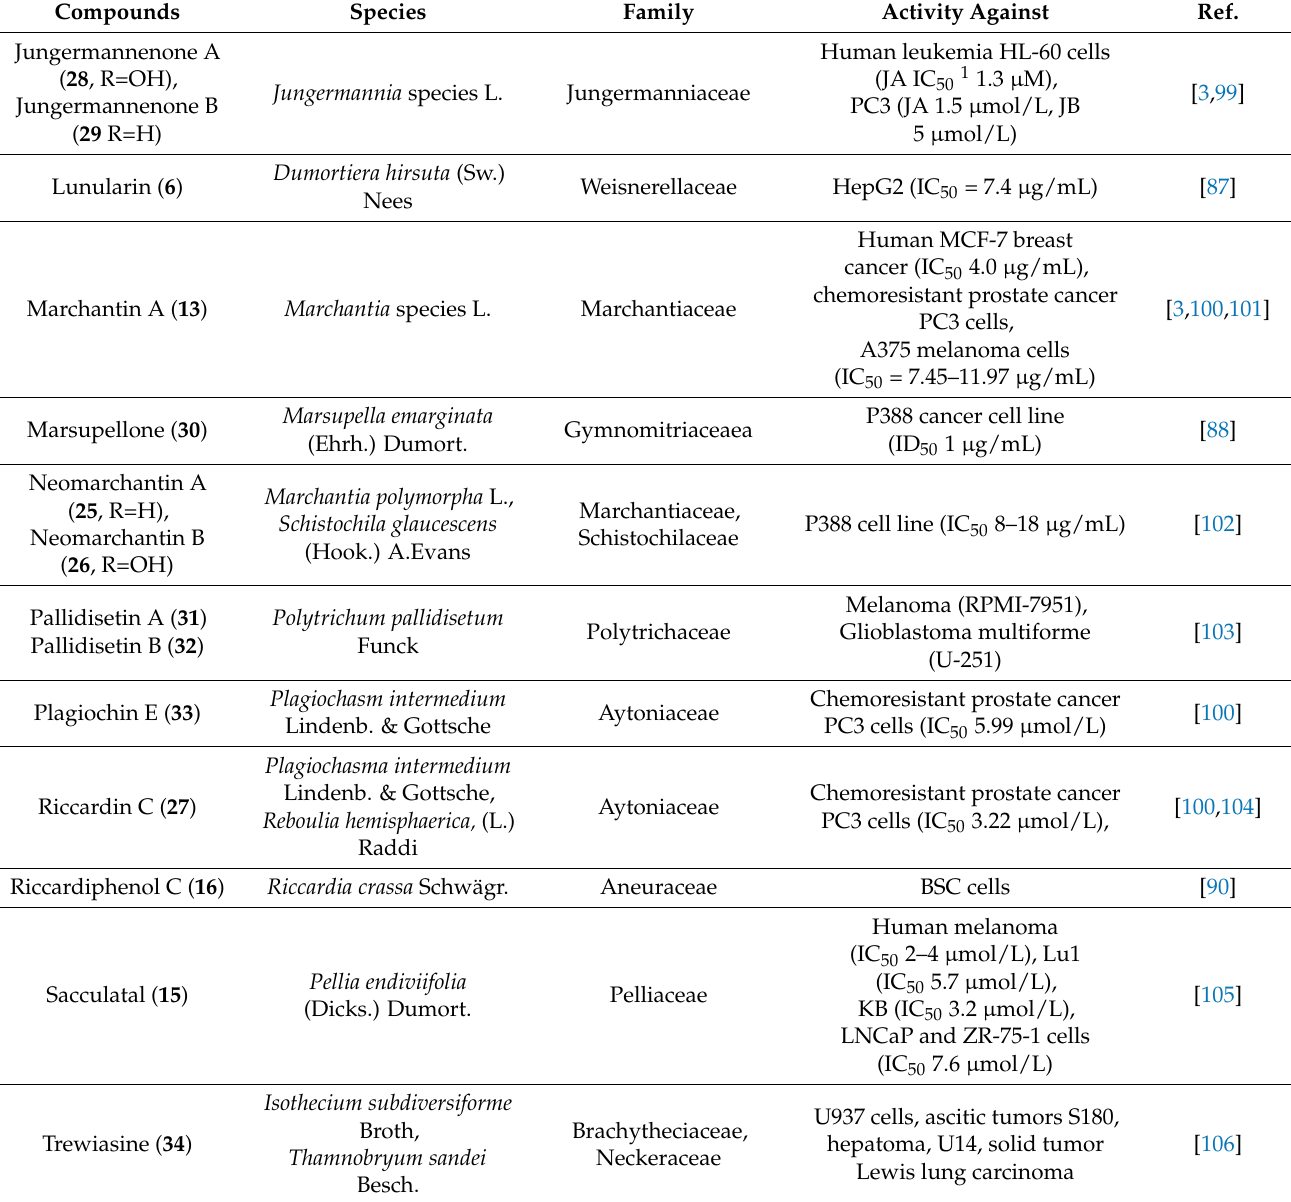
Table 6. Cytotoxic compounds isolated from bryophytes with modern